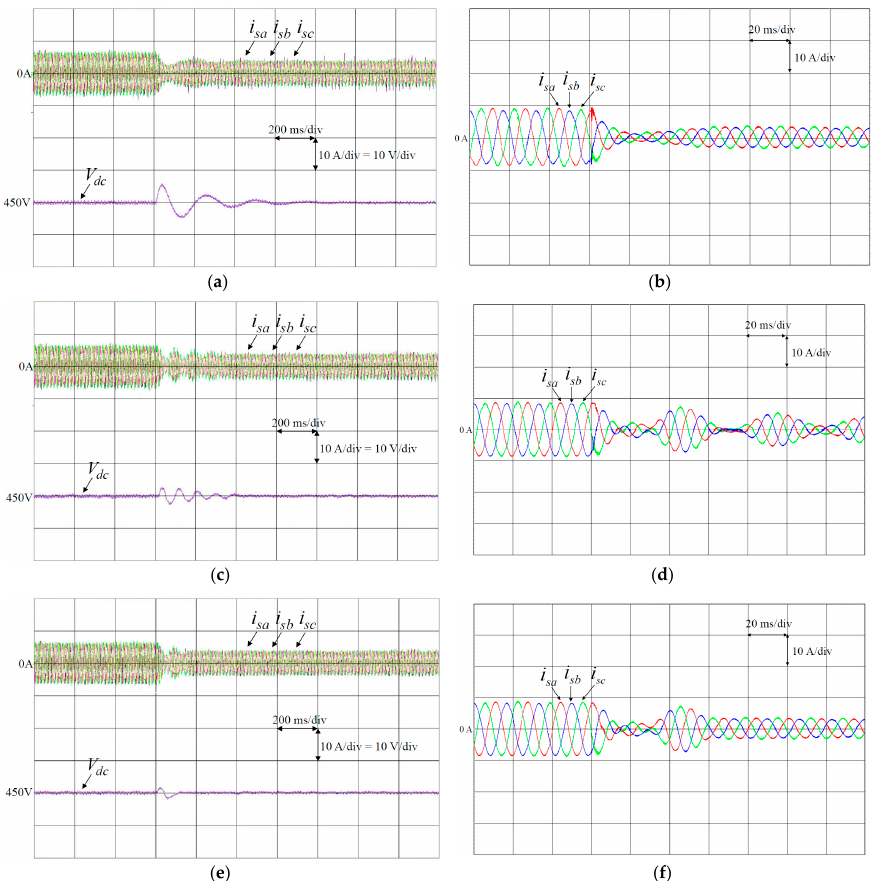
Figure 10. Experimental results at case 2: ( a ) Responses of three-phase currents i sa , i sb , i sc and regulation control of DC-link voltage using PI controlled shunt APF; ( b ) Responses of three-phase currents i sa , i sb , i sc using PI controlled shunt APF in 0.54–0.74 s; ( c ) Responses of three-phase currents i sa , i sb , i sc and regulation control of DC-link voltage using PFNN controlled shunt APF; ( d ) Responses of three-phase currents i sa , i sb , i sc using PFNN controlled shunt APF in 0.54–0.74 s; ( e ) Responses of three-phase currents i sa , i sb , i sc and regulation control of DC-link voltage using proposed PPFNN controlled shunt APF ( f ) Responses of three-phase currents i sa , i sb , i sc using proposed PPFNN controlled shunt APF in 0.54–0.74 s.